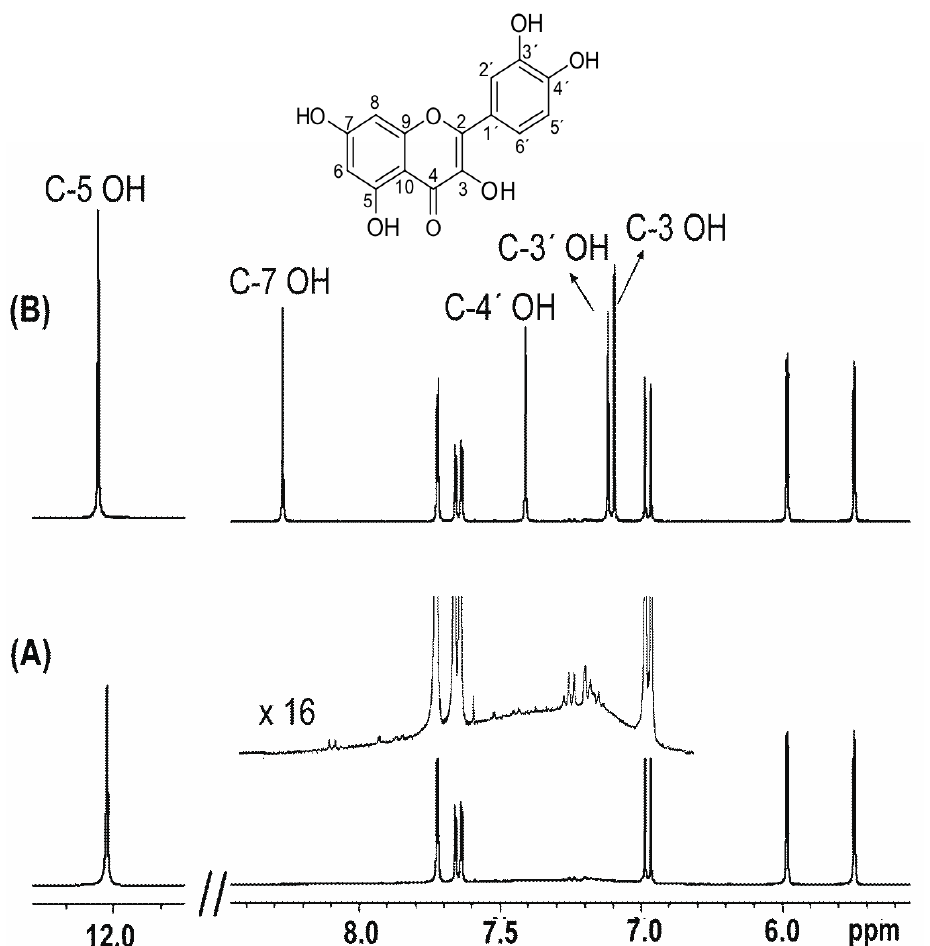
Figure 5. 1 H-NMR spectra (400 MHz) of quercetin, concentration 5 mM (T = 280 K, number of scans = 32, experimental time = 4 min) in ( A ) CD vertical expansion (×16), and ( B ) the same solution as in ( A ) with the presence of 2 μL picric acid, 8 mM. Reprinted with permission from [25]. Copyright 2013, The Royal Society of